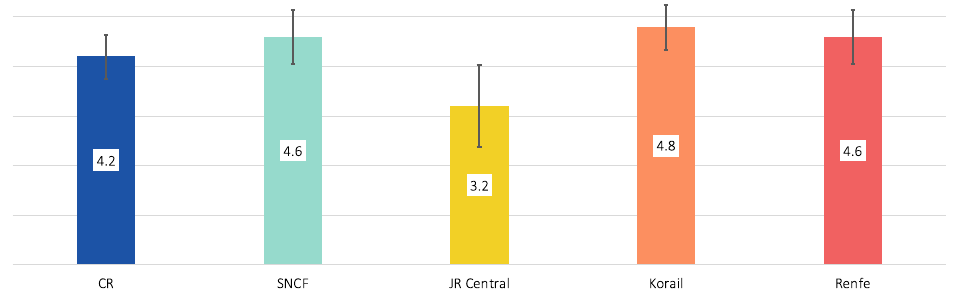
Figure 9. The degree to which railway specialists agree with the benchmarking analysis carried out by networks.